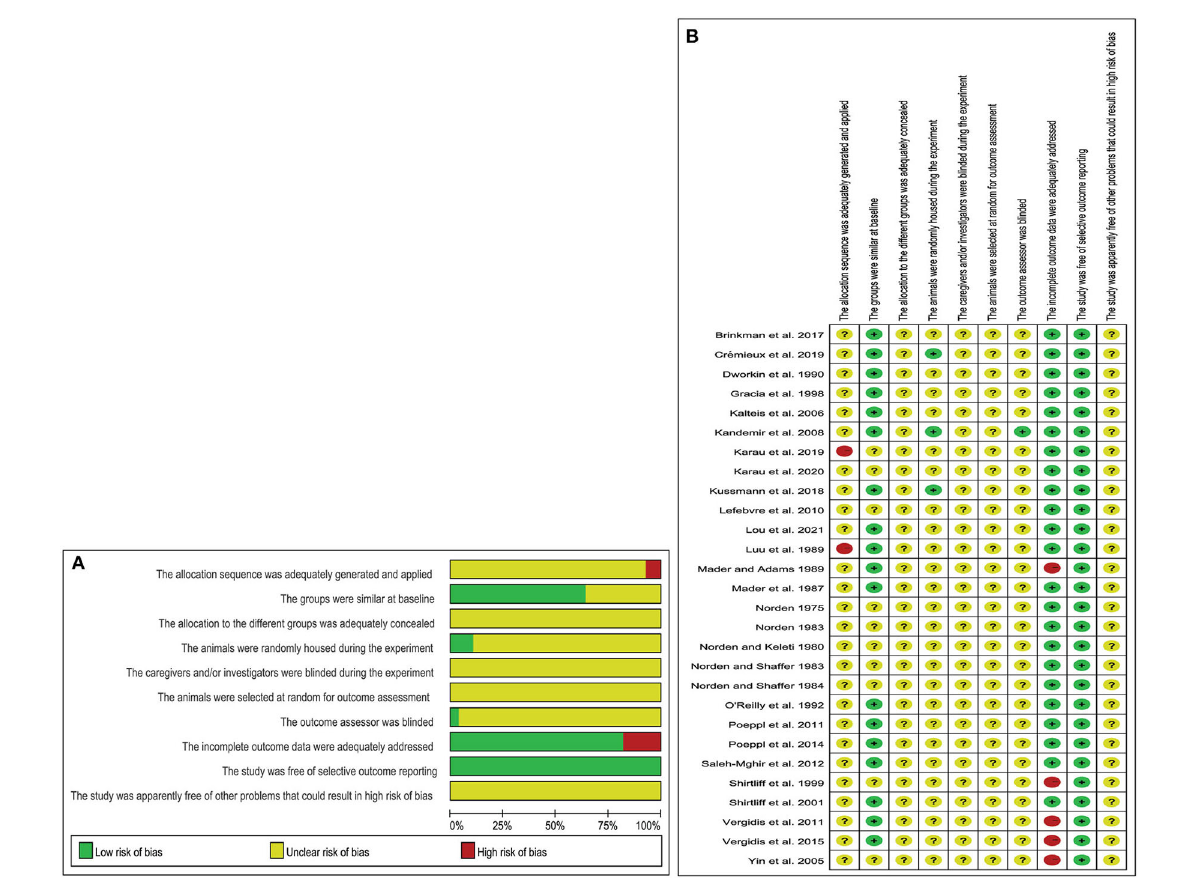
FIGURE2 Risk of bias (A) graph showing the risk of bias; (B) individual risk of bias for each of the included animal studies.